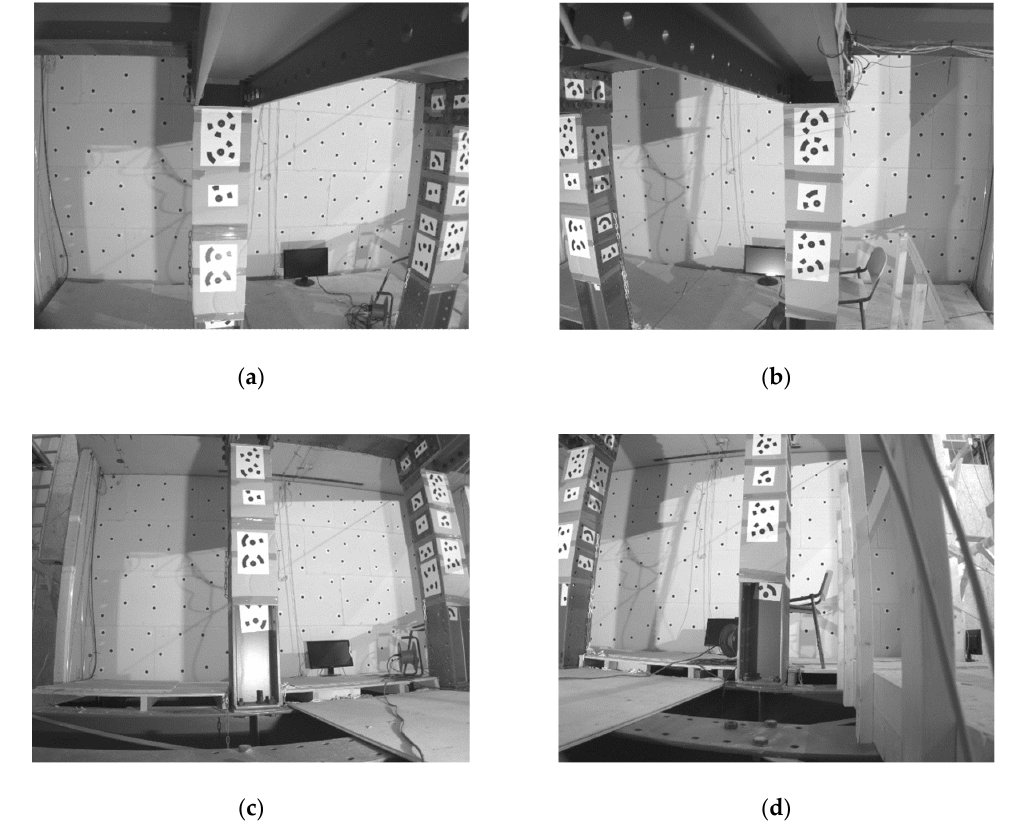
Figure 6. Field of view captured by each camera: ( a ) the top-left, ( b ) the top-right, ( c ) the bottom-left, and ( d ) the bottom-right cameras.